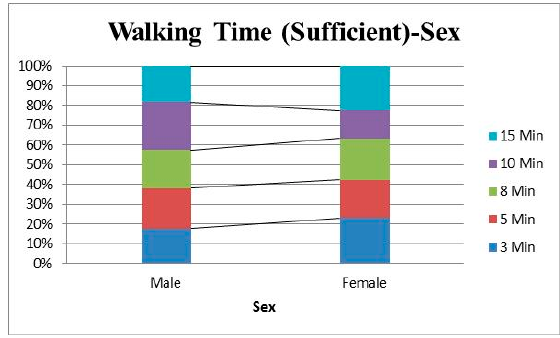
Figure A5. Relationship between walking time and sex for PHEV with sufficient charge.